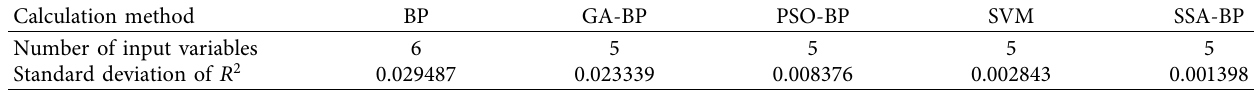
Table 10: Stability analysis of different calculation